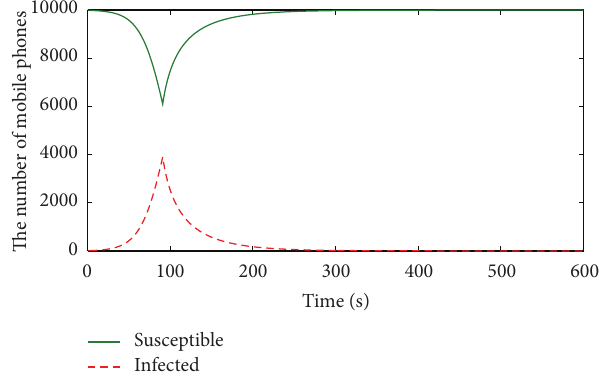
Figure 4: Numerical results in the M-SIS